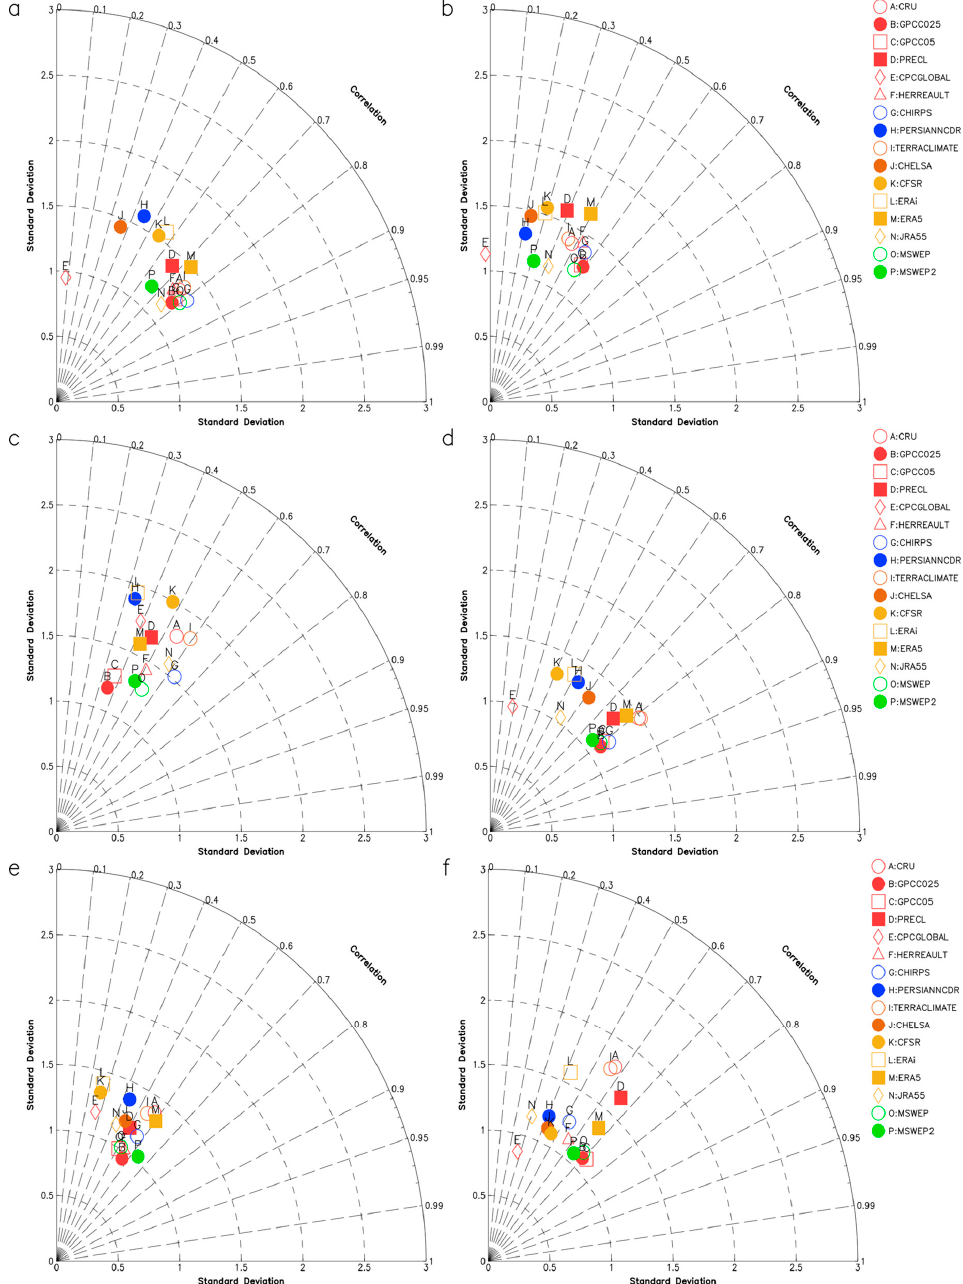
Figure 8. Taylor diagrams for the areas with SPI lower than − 0.5 ( a ), moderate and severe droughts ( b , c , respectively). SPI greater than 0.5 as well as moderate and severe wet conditions are shown in ( d – f ), respectively.